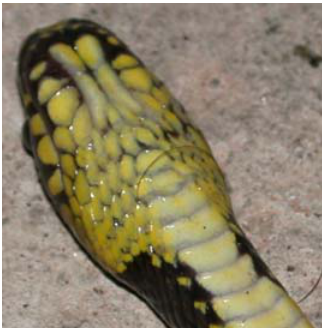
Image 3. Ventral view of the head of Dinodon gammiei from Chungthang, northern Sikkim showing larger posterior